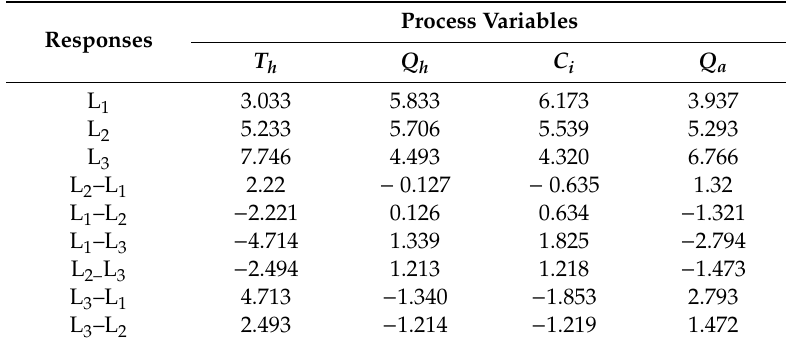
Table 4. Responses for the Taguchi analysis of the permeate fluxes; T h (feed temperature), Q h (feed flow rate), C (feed concentration), and Q a (sweeping gas flow